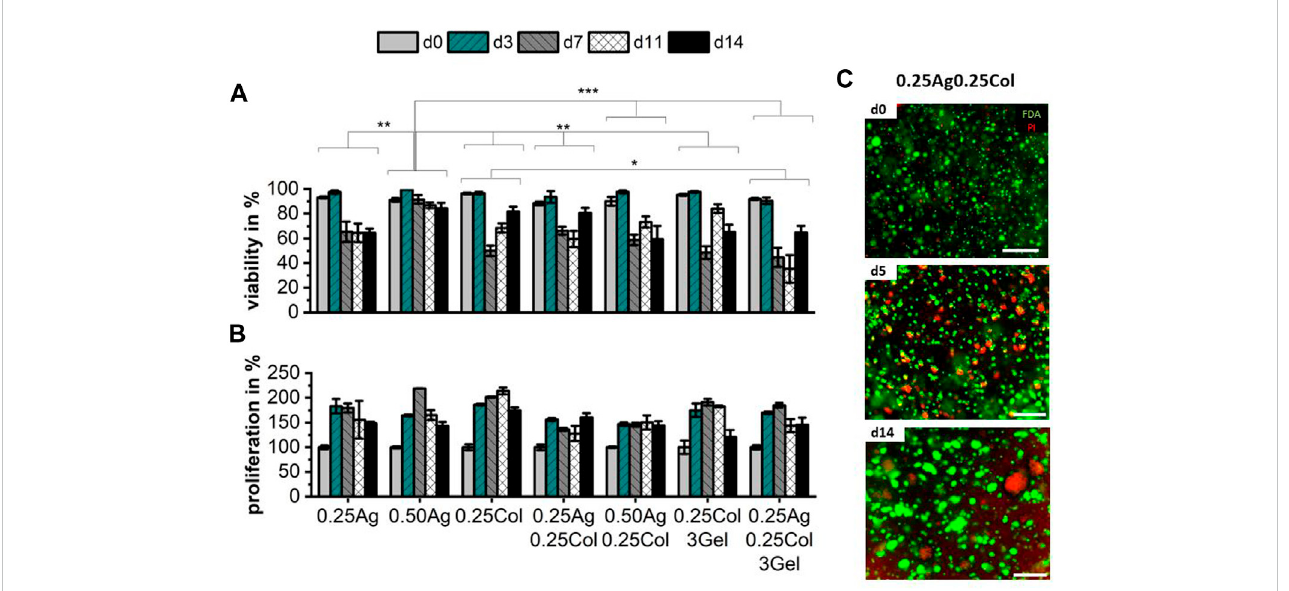
FIGURE 5 Cellviability (A) andproliferation (B) of1×10 6 cells/mlofHepG2 cellsinagarose,collagenandgelatin blendsoverthecourseof14days;n=3withnsfor no signi fi cance, * for p < 0.05, ** for p < 0.01 and *** for p < 0.001. Exemplary images of HepG2 in 0.25Ag0.25Col stained with FDA for live (green) and PI for dead (red) cells on days 0, 5 and 14 show increasing size and number of agglomerates with necrotic cores (C) . Scale bar showing 500 µm.